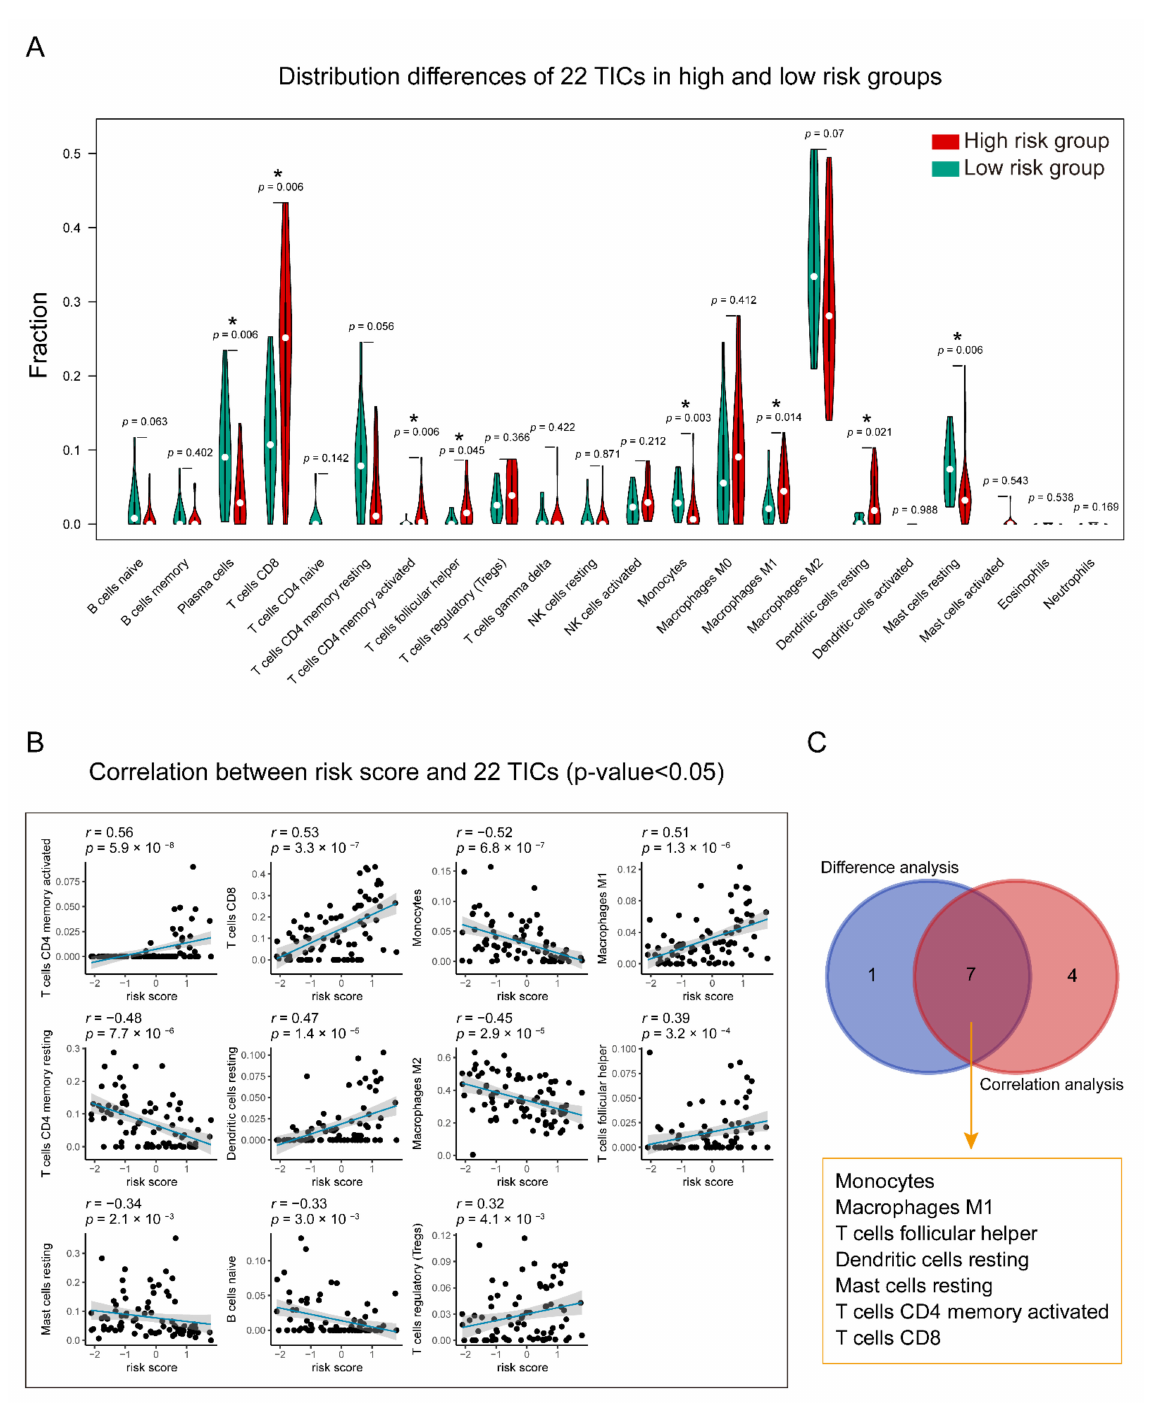
Figure 10. Relationship between TICs and seven-gene signature risk score. ( A ) The Violin plot shows the ratio differentiation of each of 22 TICs between high- and low-risk groups. Wilcoxon rank-sum was applied for the significance test. ( B ) The correlations between the TICs and seven-gene signature risk score (only correlations with significate were plotted). The blue line in each graph fits a linear model that indicates the proportional trend of the TICs and the risk score. The grey shading around the blue line indicates the 95% confidence interval. Correlation test is conducted by the Spearman coefficient. ( C ) The Venn diagram exhibits that the seven TICs have a strong correlation with the risk score. This strong correlation is co-determined by the results of the violin and scatters plots. p -value < 0.05 is the significance threshold. UM: uveal melanoma; TIC: tumor-infiltrating immune cell; * p -value <